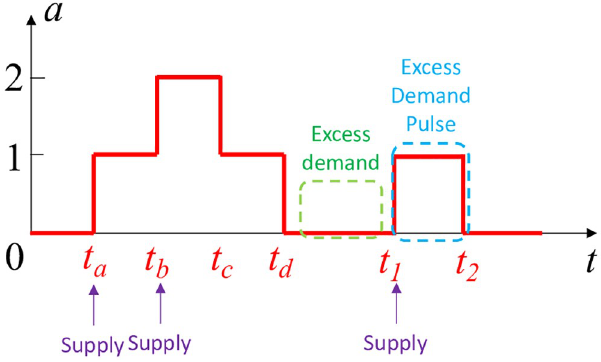
Fig 4. A segment of bike availability curve to illustrate the estimation of excess